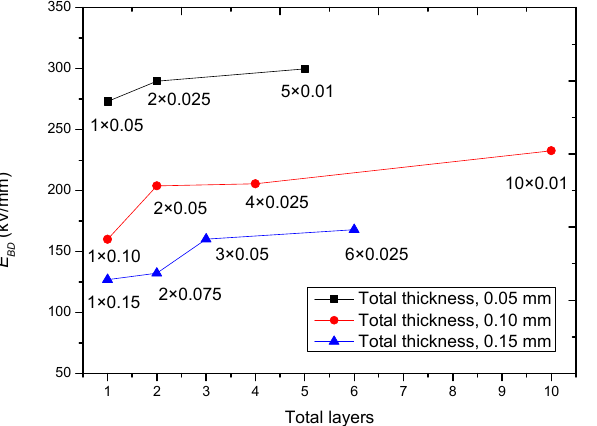
Figure 7. E BD of multi-layer films with a fixed total thickness dependent on different layers. The raw data are from [29].